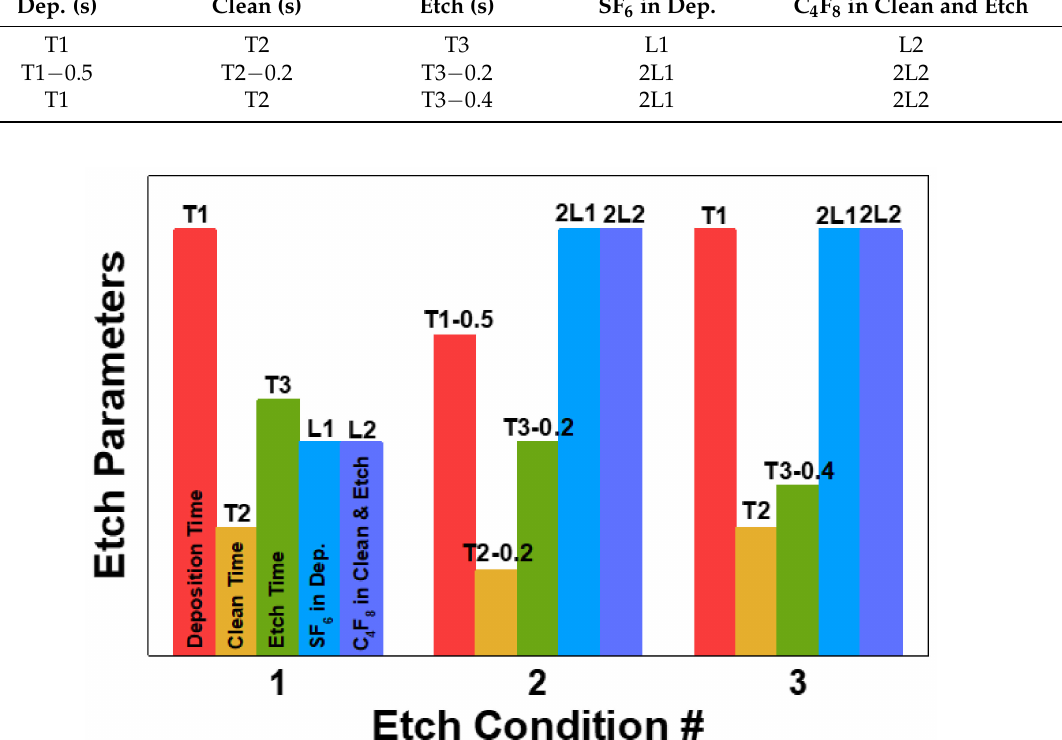
Figure 1. Comparison of etch parameters among three etch